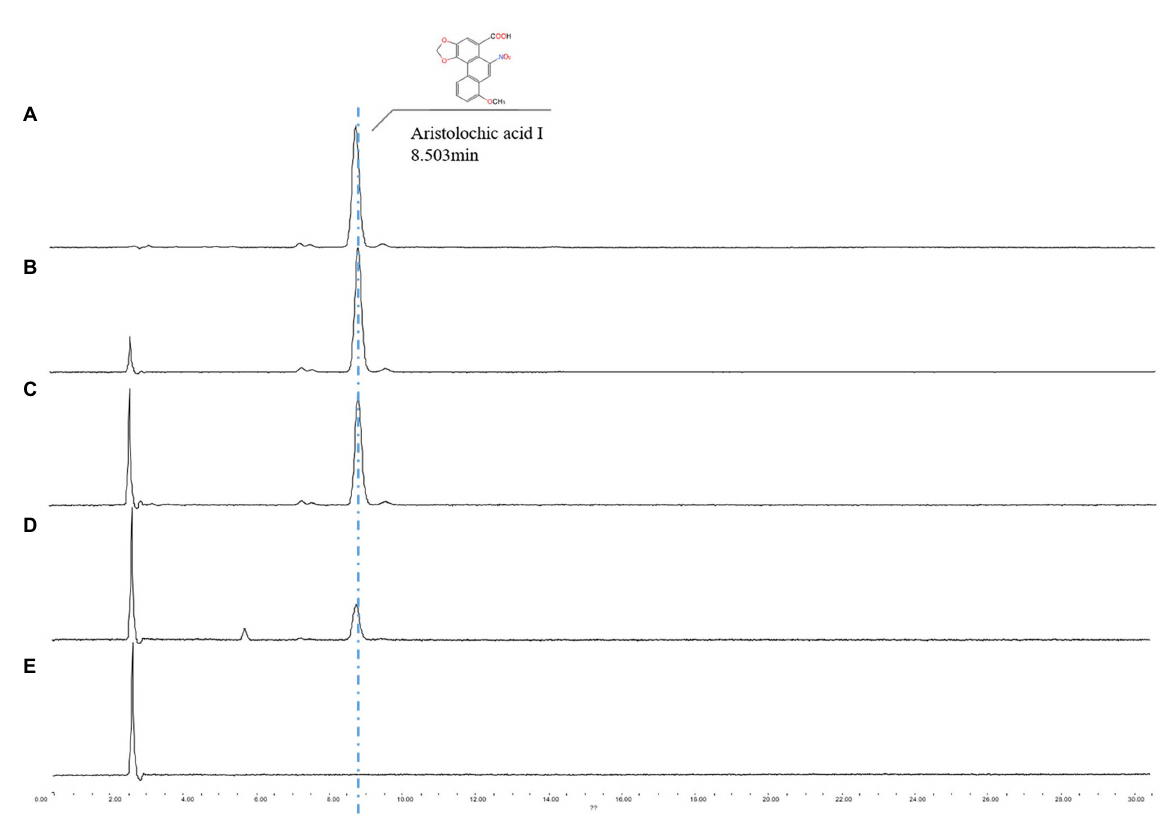
FIGURE 4 UPLC spectrum analysis of A.h-Fs-1 degradation of AAI. (A) Minimal medium containing AAI (0.515 mg/ml). (B) Minimal medium containing AAI for a degradation time of 14 days. (C) Minimal medium containing AAI and A.h-Fs-1 for a degradation time of 5 days. (D) Minimal medium containing AAI and A.h-Fs-1 for a degradation time of 14 days. (E) Minimal